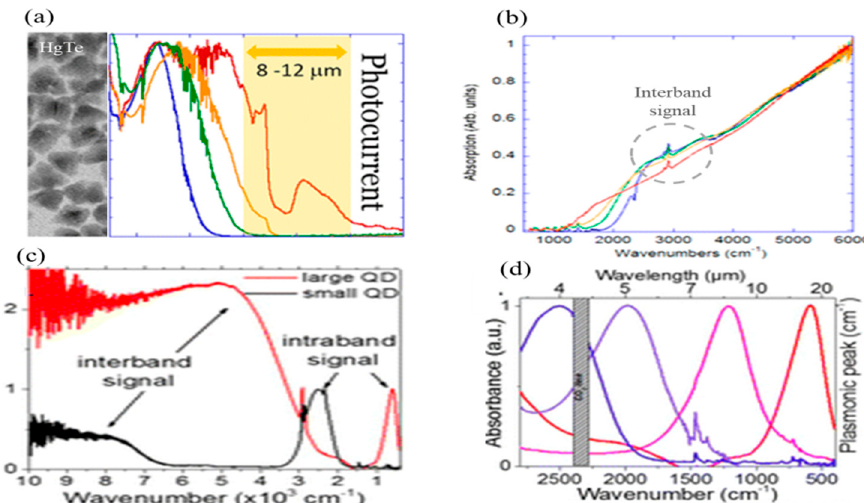
Figure 4. ( a ) TEM image of HgTe CQDs with broadband photo-response; ( b ) shows the electron transitions for corresponding wavenumbers (reproduced with the permission of Reference [75], Copyright 2014, American Chemical Society); ( c ) The intraband transition spectra and ( d ) absorption spectra in HgSe CQD-based photodetectors (reproduced with the permission of Reference [20], Copyright 2016, American Chemical Society).